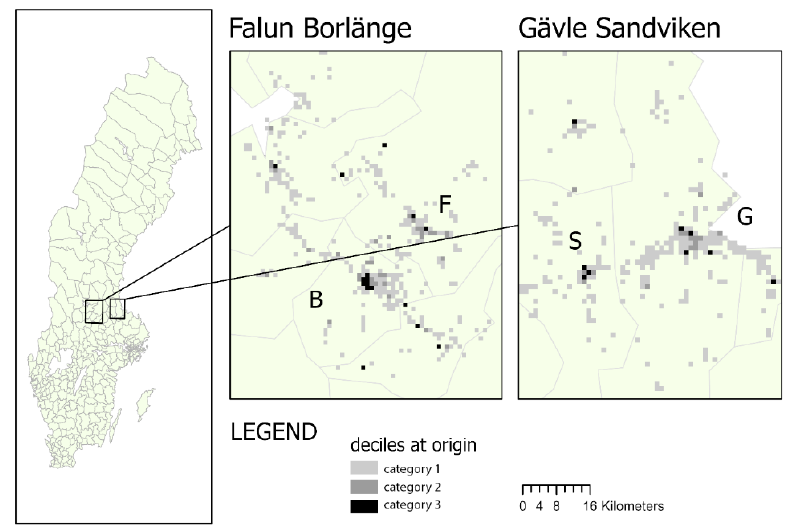
Figure 1. Distribution of km 2 units by category in the two labour market regions. Notes: Empty areas are unpopulated. The map of Sweden indicates the location of the two